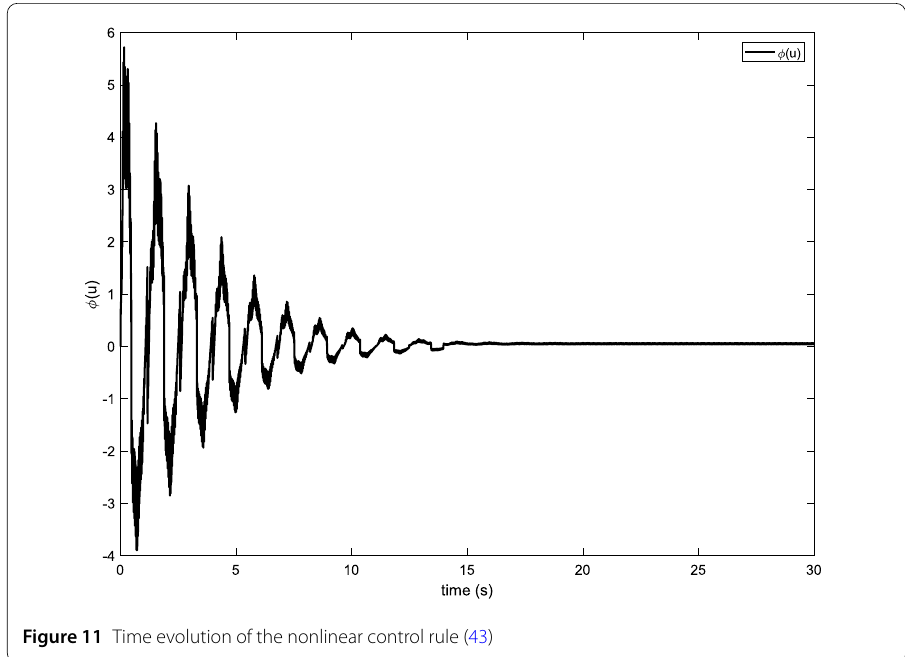
Figure 11 Time evolution of the nonlinear control rule (43)